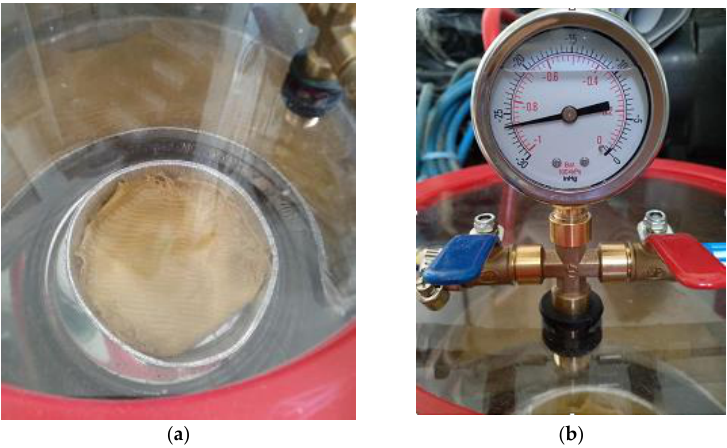
Figure 4. ( a ) Pre-impregnation of Kevlar cloth; ( b ) vacuum gauge. Polymers 2021 , 13 , x FOR PEER REVIEW